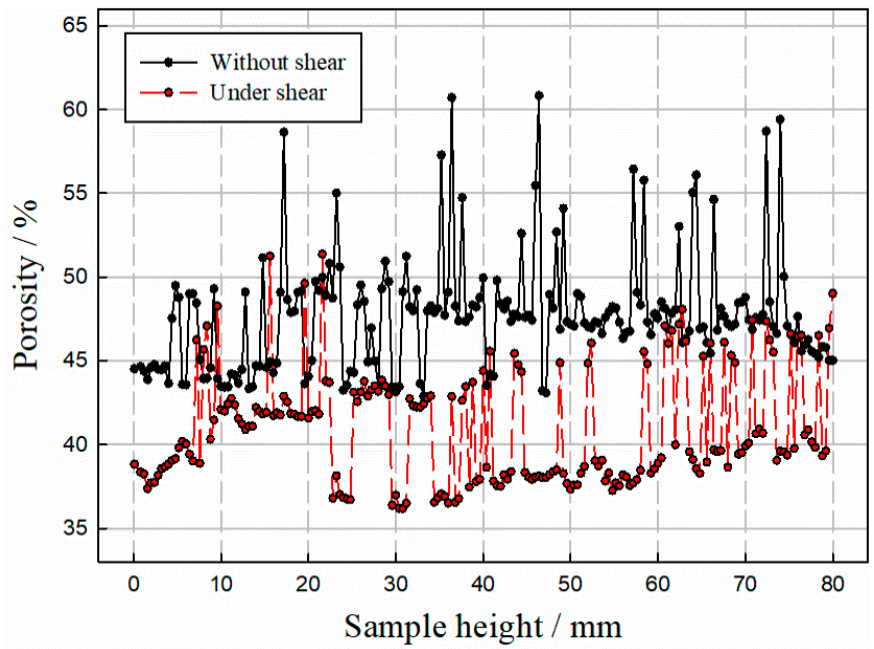
Figure 13. Variation pattern of porosity with sample height under no/with shear conditions.